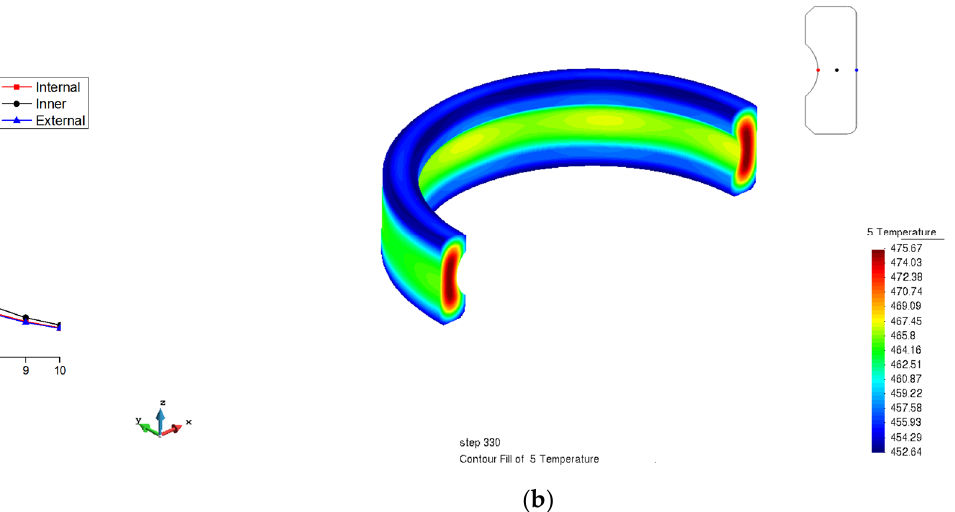
Figure 10. Analysis of the temperature field for axial symmetry heat transfer. ( a ) Temperature versus time curve during quenching; ( b ) temperature field at 10 s quenching.